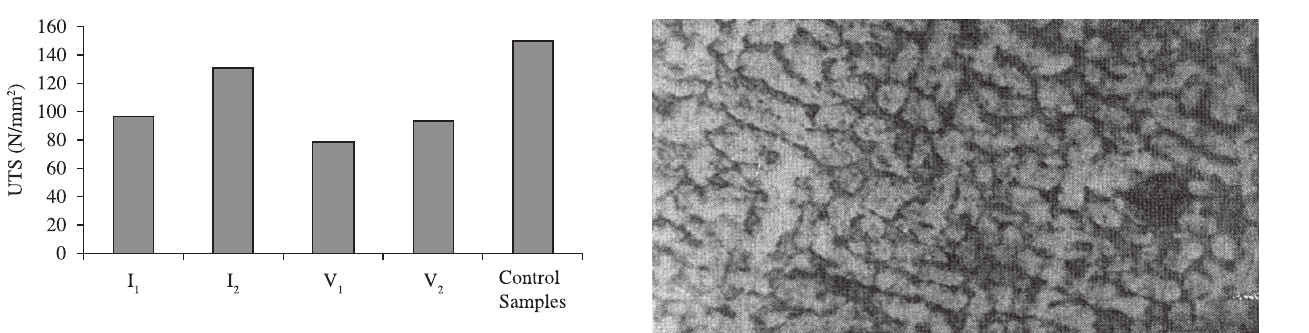
Figure 1. Average value of the ultimate tensile strength (UTS) of the samples at the various welding conditions in N.mm –2 .